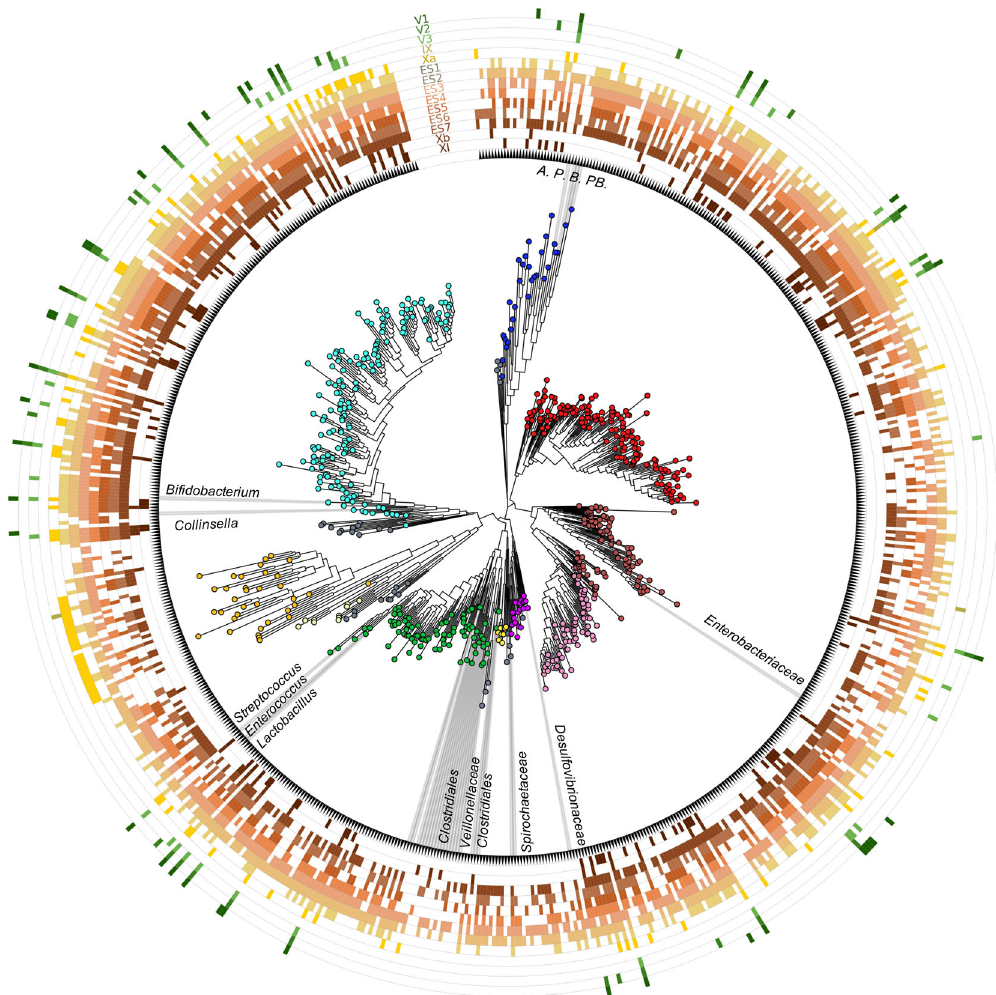
Fig. 3 Ancient bacteria in sediment samples from El Salt. The phylogenetic tree was built with representative sequences of bacterial genera for which at least one species was present with more than four hits in one sample. Different colors indicate different phyla (or classes for Proteobacteria) as follows: cyan, Actinobacteria; blue, Bacteroidetes; red, Alphaprotebacteria; brown, Gammaproteobacteria; pink, Betaproteobacteria; purple, Deltaproteobacteria; yellow, Acidobacteria; green, Firmicutes; light-yellow, Planctomycetes; orange, Euryarchaeota; grey, others (including Armatimonadetes, Chlorobi, Chloro fl exi, Cyanobacteria, Deinococcus-Thermus, Fusobacteria, Gemmatimonadetes, Nitrospirae, Spirochaetes, Synergistetes and Verrucomicrobia). Bacterial taxa belonging to families common to the gut microbiome of hominids are highlighted at different taxonomic level. A, Alistipes ; P, Prevotella ; B, Bacteroides ; PB, Parabacteroides